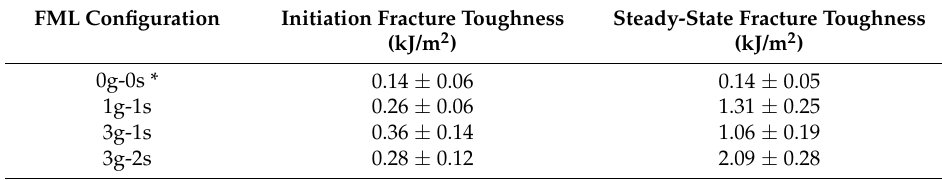
Table 2. Initiation and steady-state fracture toughness values determined via mode I